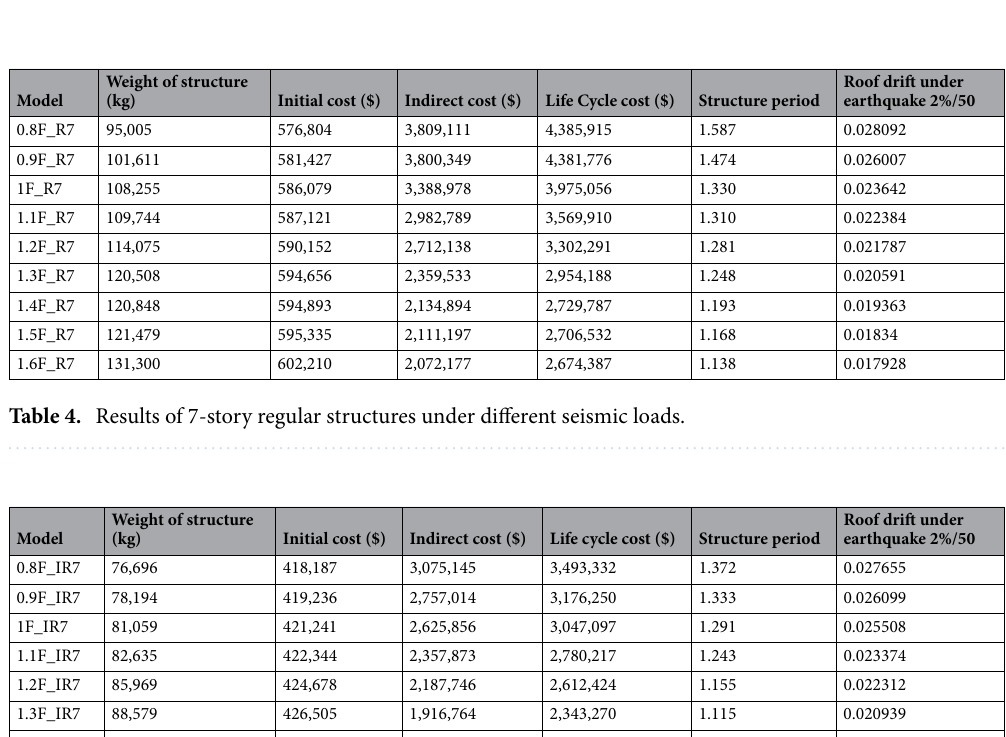
Table 3. Calculation of LCC for case 1.4F_IR7.